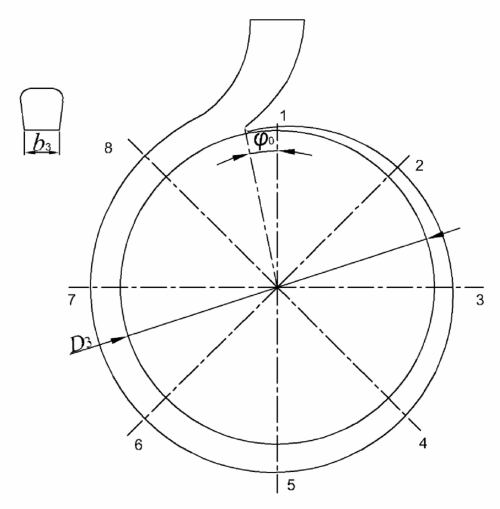
Figure 3. Geometric parameters of the